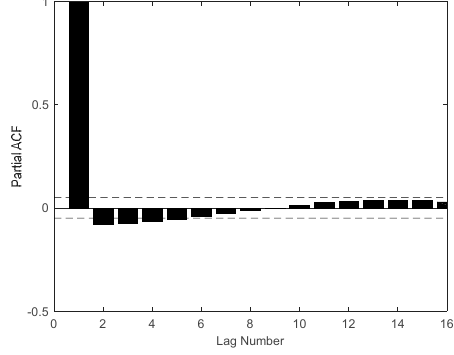
Figure 10. The PCAF results of the EUA spot price after MRSVD.